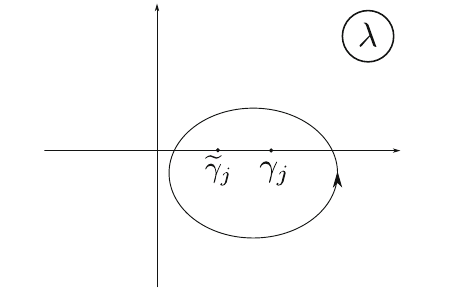
Fig. 8 Integration contour for the projection onto V ( B t ,γ j , (cid:10) γ j